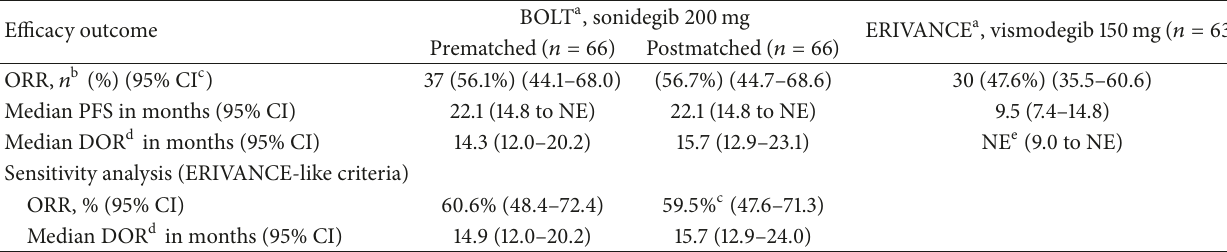
Table 5: Efficacy outcomes